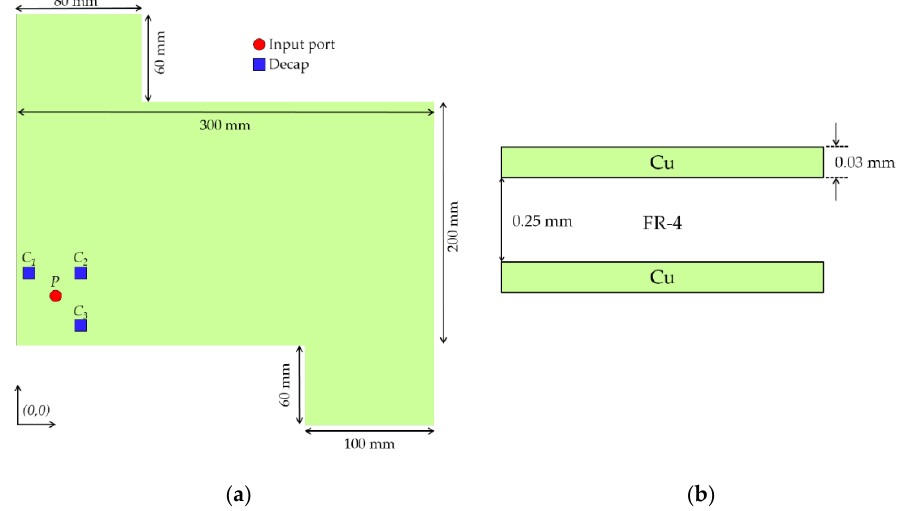
Figure 1. ( a ) Test boards and ( b ) its stack-up. The red circle represents the input port P from which the input impedance Z in in evaluated by EZpp and design force (DF) power integrity (PI), whereas C 1 , C 2 , and C 3 are the three decoupling capacitors whose values have to be optimized by the genetic algorithm (GA).